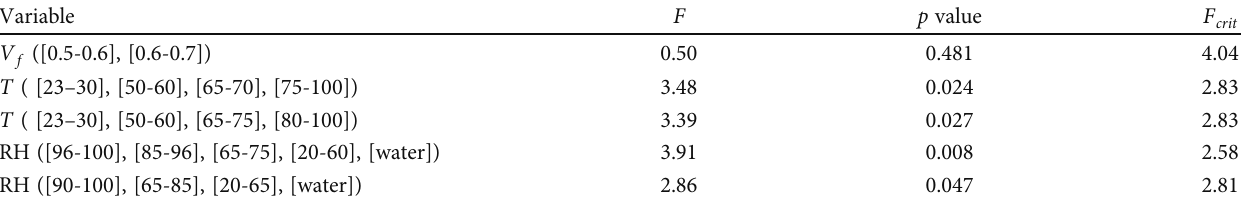
Table 1: ANOVA F -test analysis for di ff erent variables a ff ecting D